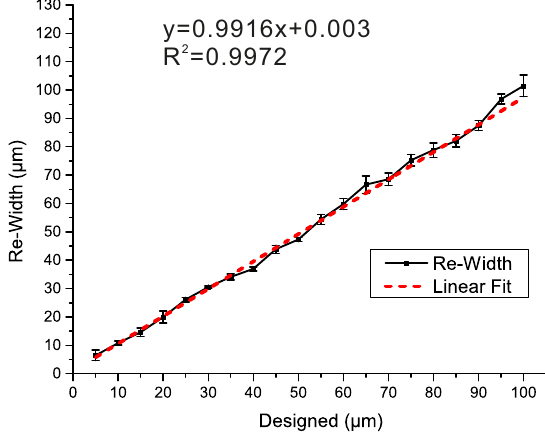
Figure 3. The relationship between the designed size and the actual size of the structure.